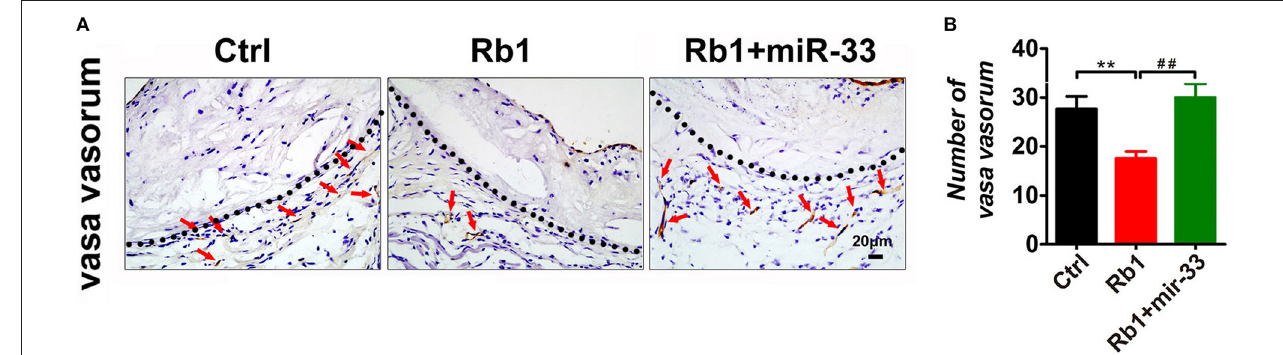
FIGURE 3 | Analysis of VV expression in atherosclerotic plaques of apoE − / − mice. (A) Histological analysis of adventitial VV proliferation at aorta roots of control group, Rb 1 -treated group as well as Rb 1 + miR-33 treated apoE − / − mice, by staining with Tomato lectin ( n = 6/group). Tunica media and adventitia are separated by dotted lines. (B) Quantification of VV number in control group, Rb 1 -treated group and Rb 1 + miR-33 treated apoE − / − mice ( n = 6/group). ** p < 0.01; ## p < 0.01, one-way